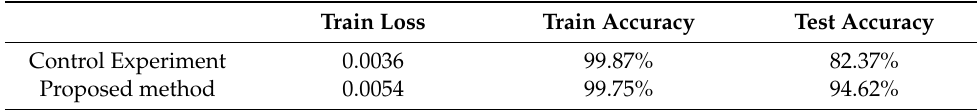
Table 1. The results of the pipeline classification